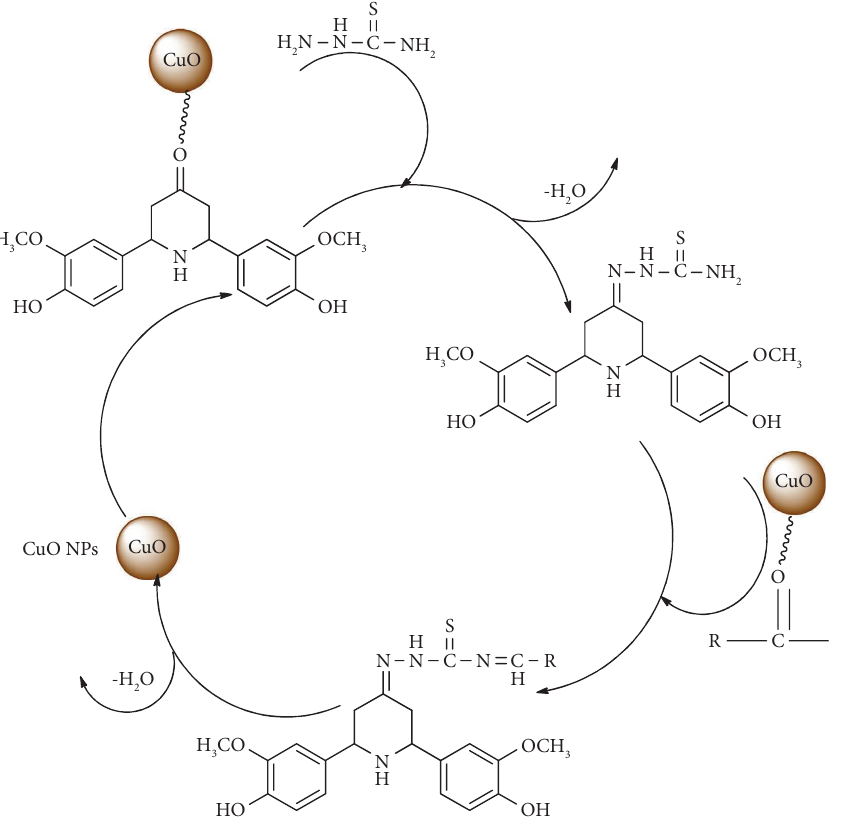
Scheme 3: Proposed mechanism of vanillin derivatives synthesis using a CuO NPs catalyst.